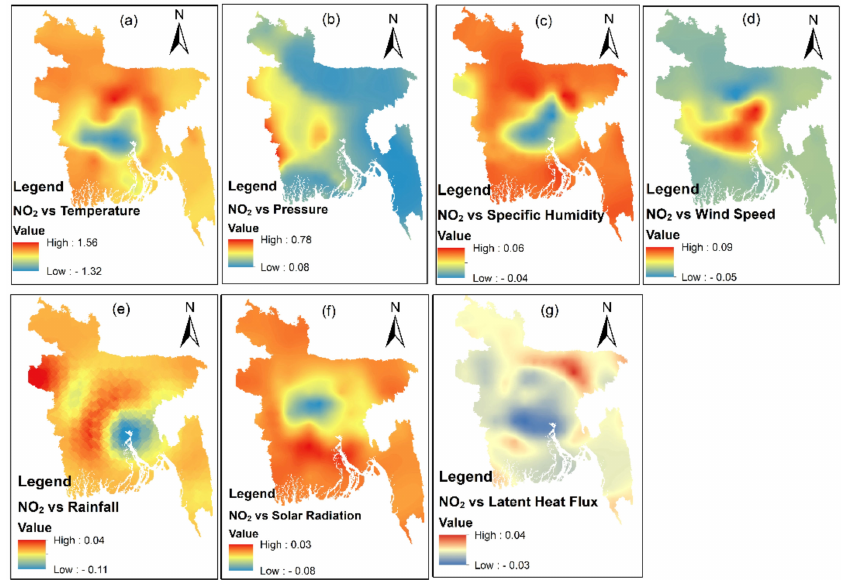
Figure 8. Spatial representation of the relationship between NO 2 and meteorological variables using the geographically varying coefficients from GWR modelling over Bangladesh during 2015–2020: ( a ) temperature, ( b ) pressure, ( c ) specific humidity, ( d ) wind speed, ( e ) rainfall, ( f ) solar radiation, and ( g ) latent heat